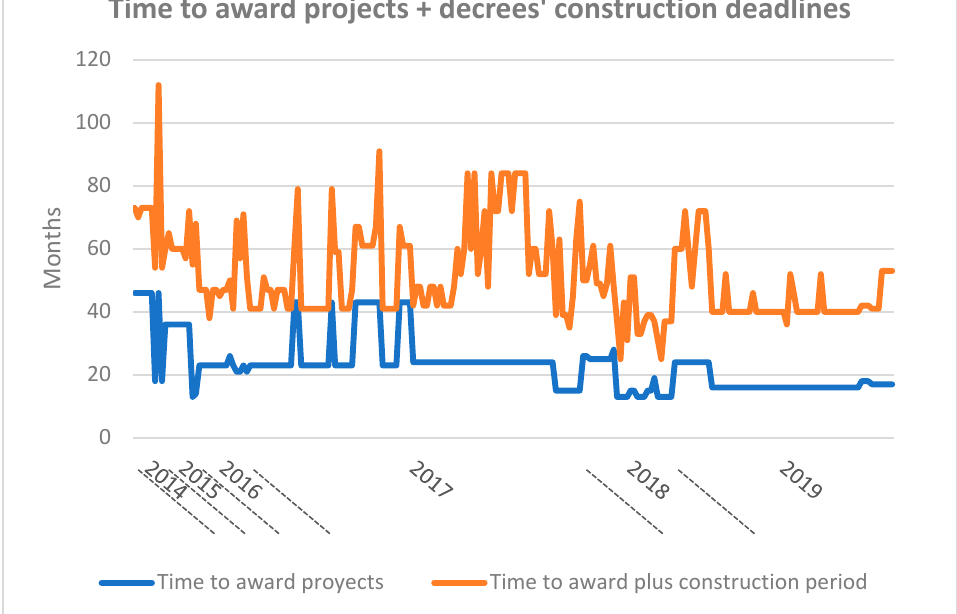
Figure 3. Time to award projects + decree’s construction deadlines. Projects’ location on the horizontal axis follows their order of appearance in the respective decrees. Source: Own elaboration based on Coordinator’s data and Expansion Plan Decrees. The data for Figure 3 can be downloaded at Supplementary Materials.